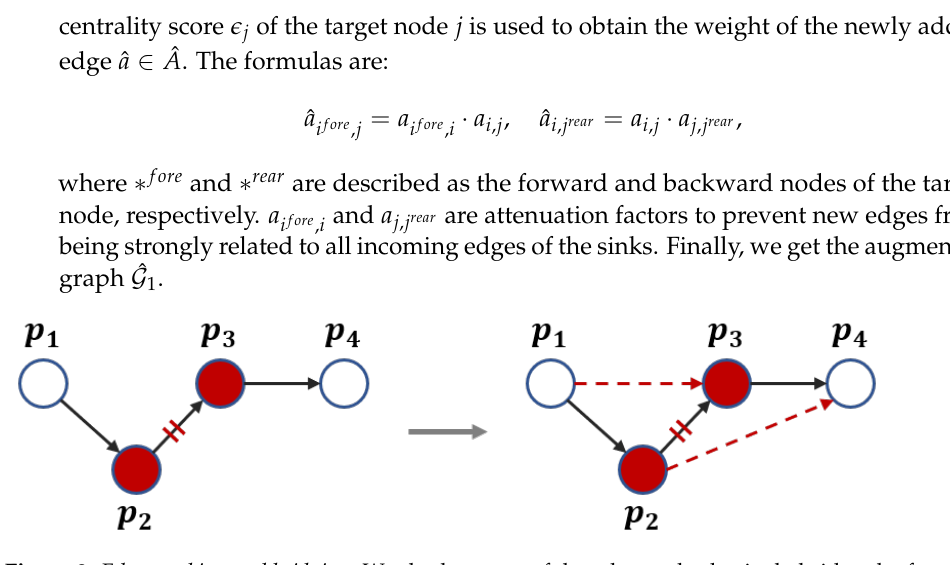
Figure 3. Edge masking and bridging . We shadow part of the edge and selectively bridge the forward and backward nodes at both